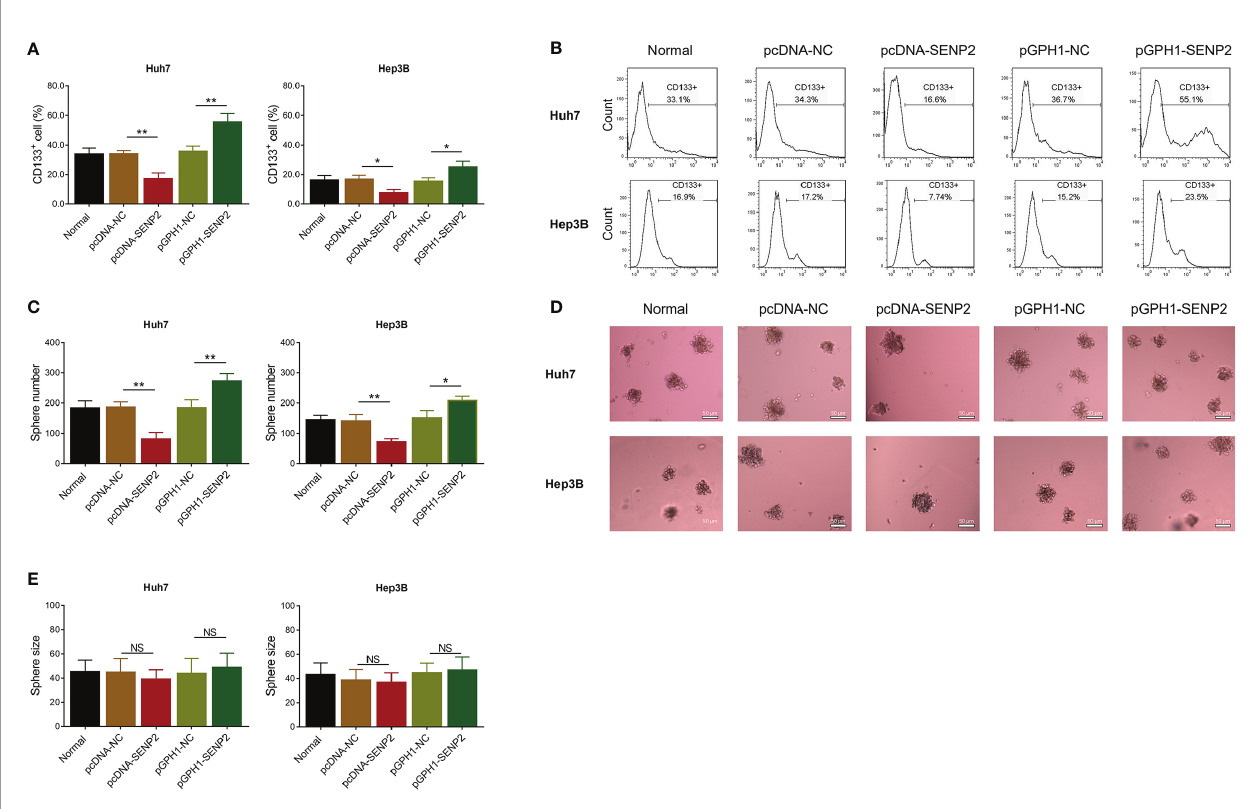
FIGURE 3 | Stemness after plasmid transfection. Comparison of CD133 + cell proportion among groups in Huh7 and Hep3B cells after transfection (A) . Representative images of CD133 + cell proportion detection by fl ow cytometry assay (B) . Comparison of sphere number among groups in Huh7 and Hep3B cells after transfection (C) . Representative images of sphere formation assay (D) . Comparison of sphere size among groups in Huh7 and Hep3B cells after transfection (E) . SENP2, Small ubiquitin-like modi fi er speci fi c peptidase 2; NC, negative control; CD133 + , cluster of differentiation 133 positive; * p < 0.05; ** p < 0.01; NS, not signi fi cant.